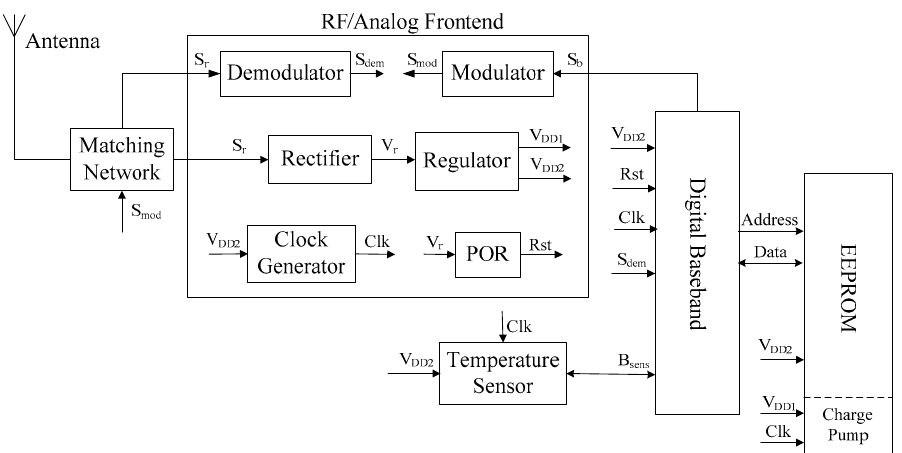
Figure 4. Structure of the proposed RFID temperature sensor tag.